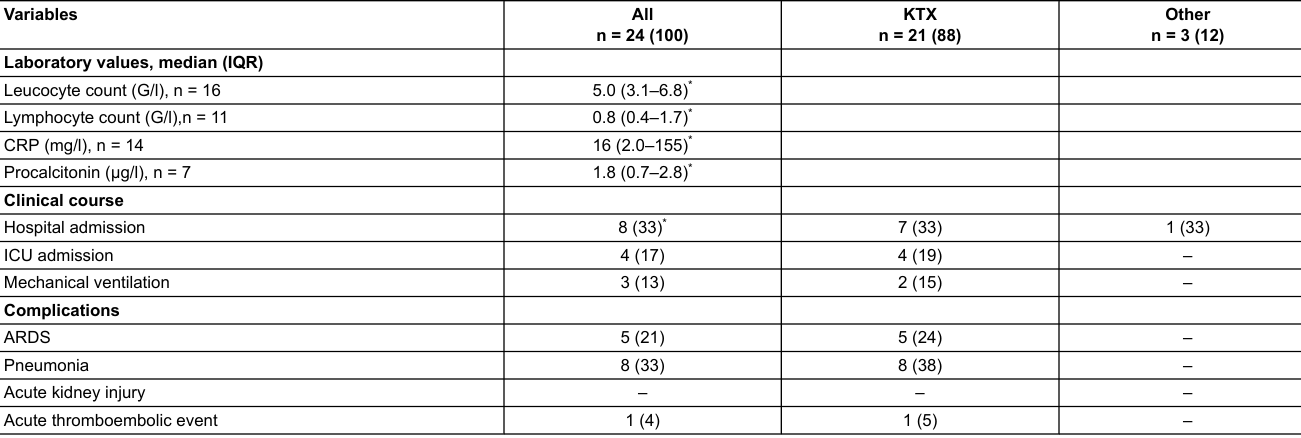
Table 3: COVID-19 clinical diagnostics and outcome.